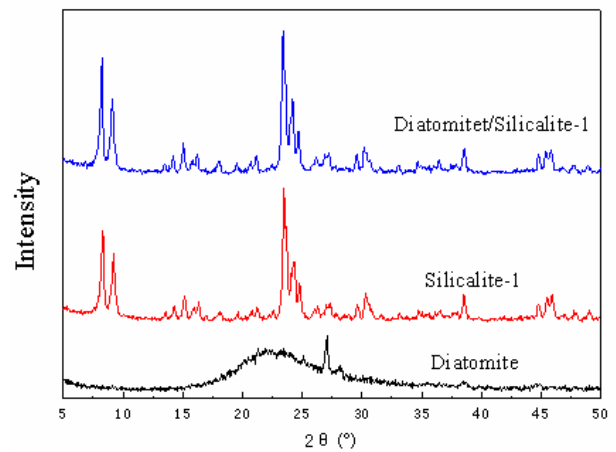
Figure 1. X-ray diffraction (XRD) patterns of diatomite (Dt), silicalite-1 (S-1) and Dt/S-1 (5 wt%).